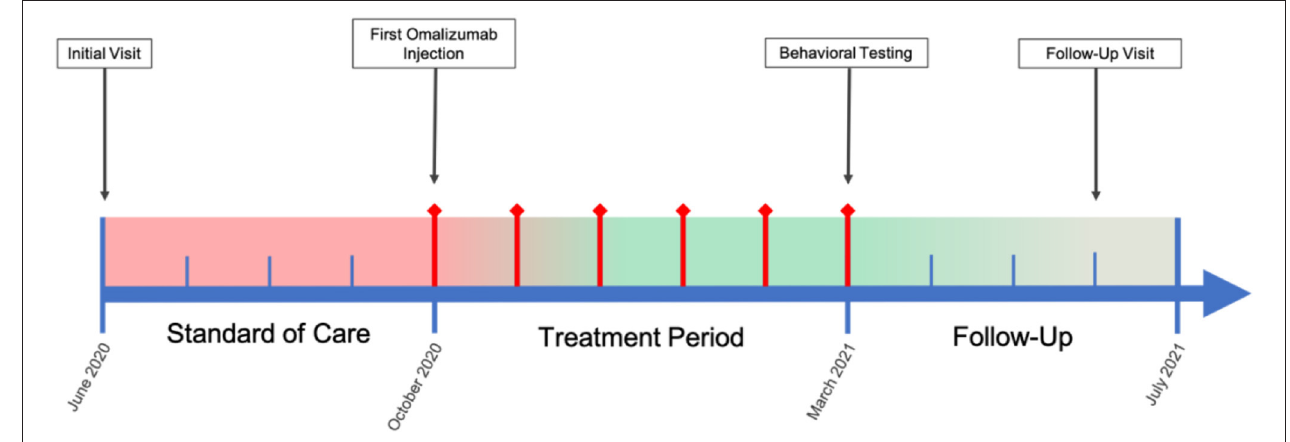
FIGURE 1 | Case Timeline. Color bar is a qualitative, visual representation of patient overall symptom severity over the course of the case, wherein red indicates severe symptomology and green mild/no symptomology. Red diamond timepoints indicate months during which omalizumab treatment was